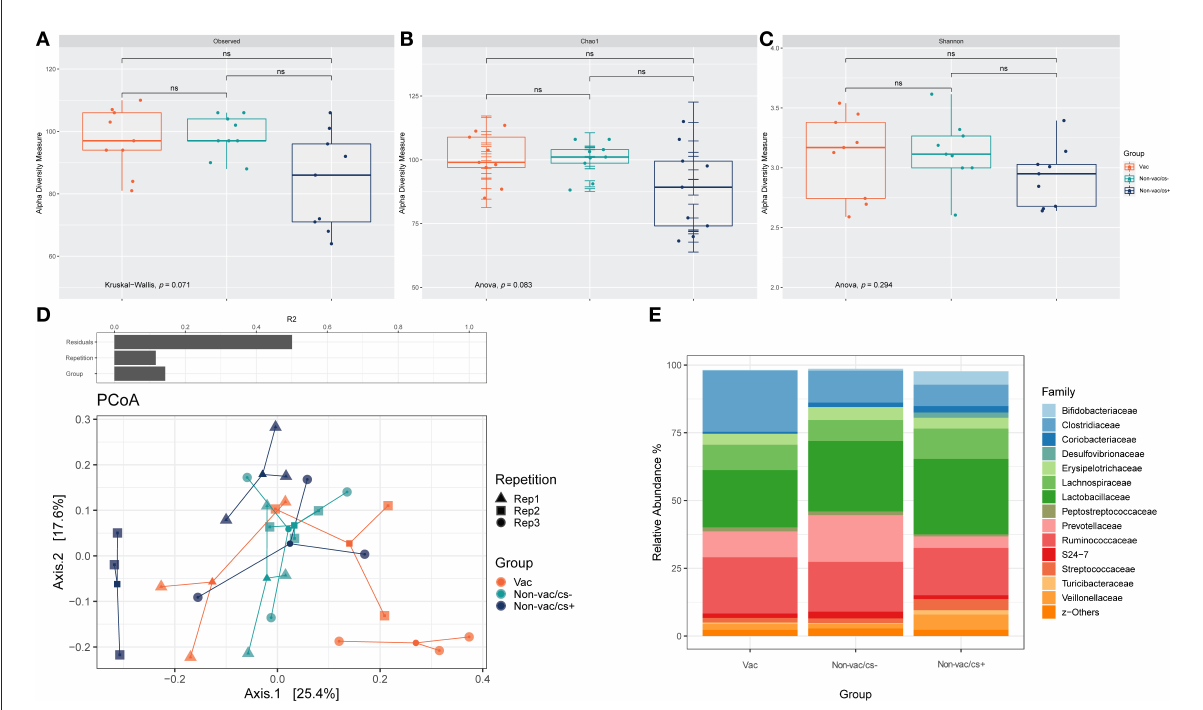
FIGURE2 Box-plots showing alpha diversity in samples using the species richness estimators (A) Observed Species, (B) Chao1, and (C) Shannon index. (D) Permutational multivariate analysis of variance (PERMANOVA) on Bray–Curtis distances was used to quantify the contribution of the factors Repetition and Group to the differences in microbial composition of the samples (above). Ordination was performed using Bray-Curtis dissimilarity-based principal coordinate analysis (PCoA). Each point, square, and triangle represents a different piglet with inconspicuous (cs–) or conspicuous (cs + ) L. intracellularis infection and different vaccination status (Vac and Non-vac) in three consecutive repetitions (Rep 1–3); colored lines connect samples of one treatment: Vac (orange), Non-vac/cs– (green) and Non-vac/cs + (blue). (E) Bar charts represent the relative abundances of the 15 dominant families in fecal samples of piglets with different vaccination status (Vac and Non-vac) and inconspicuous (cs–) or conspicuous (cs + ) L. intracellularis infection. Percentages do not total to 100% because only the 15 dominant families were considered.